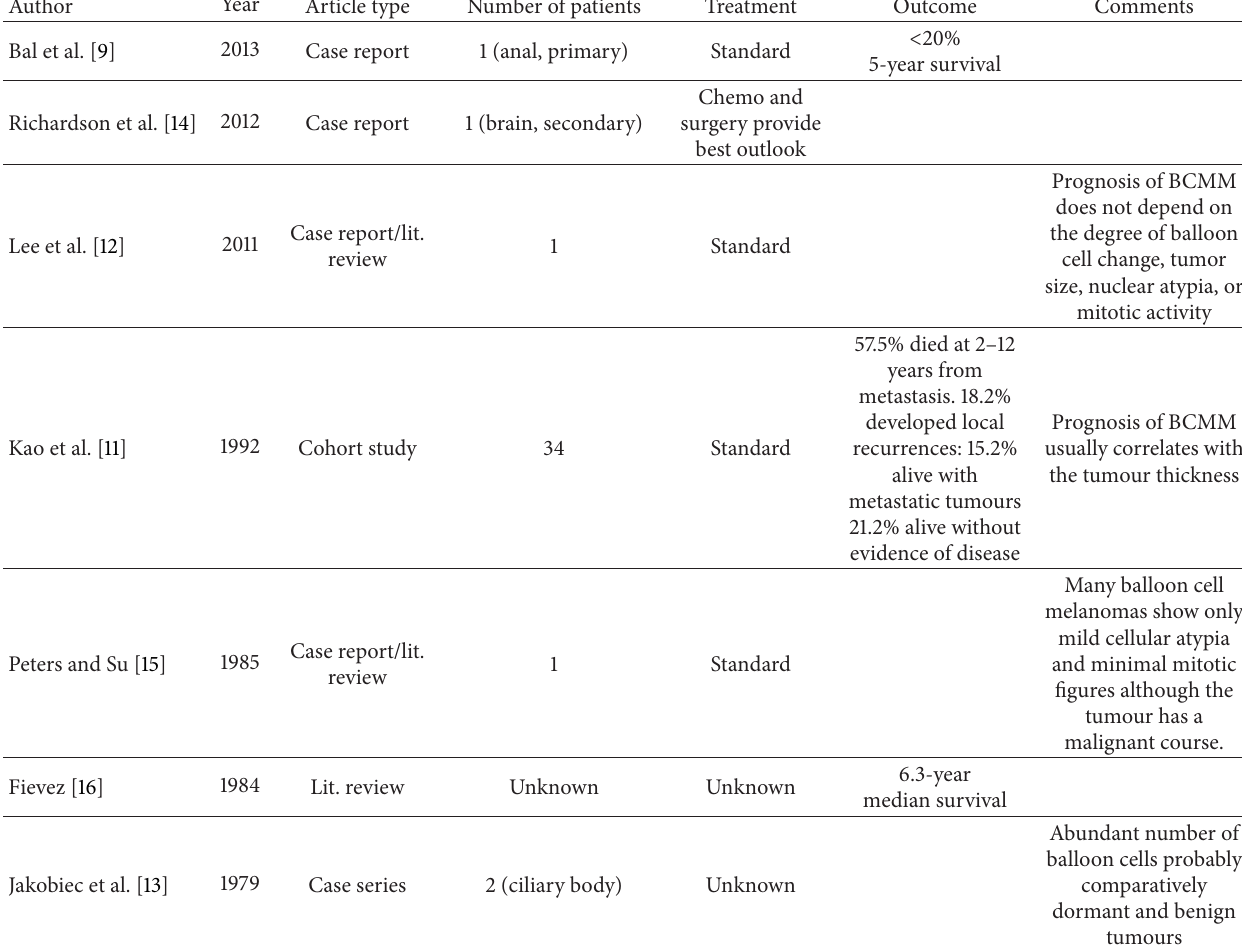
Table 1: Balloon cell melanoma literature review with focus on